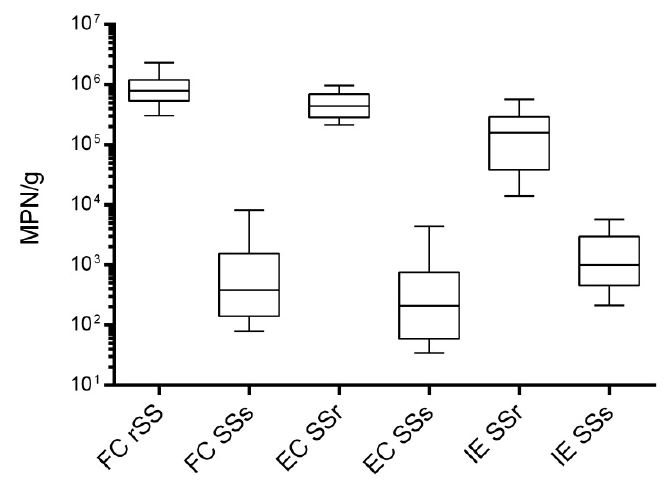
4 of 9 Figure 1. Number (MPN/100 mL) of FC, EC und IE in the untreated wastewater (WWu) and in the treated wastewater (WWt) (annual average, 90th percentile, p = 0.0001). Values are presented in a box (25th, 50th and 75th percentile) and whiskers (10th and 90th percentile) chart, (N = 54). 3.2. Bacterial Load and Reduction Rate of the Sewage Sludge Over a one-year investigation period, the median values of FIB for raw sewage sludge (SSr) were 7.94 × 10 5 MPN/g for FC, 4.41 × 10 5 MPN/g for EC and 1.60 × 10 5 MPN/g for IE, all in a comparable magnitude. Median values for stabilized sewage sludge (SSs) were 3.84 × 10 2 MPN/g for FC, 2.20 × 10 2 MPN/g for EC and 1.01 × 10 3 MPN/g for IE. The number of IE was high in the SSs, which was the reverse of